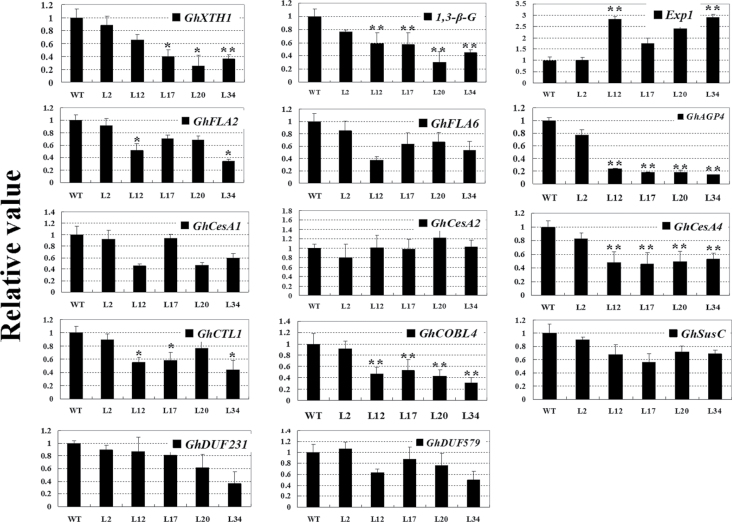
Real-time quantitative RT-PCR analysis of expression of genes related to fibre elongation and SCW synthesis in fibres of transgenic cotton plants. Total RNA was isolated from 20 DPA fibres of transgenic cotton plants (L2, L12, L17, L20, and L34) and the wild type (WT) and analysed by real-time quantitative RT-PCR; GhUBI1 was used as a quantification control. Expression levels of fibre development-related genes in transgenic plants were normalized compared with WT. The examined genes were XHT1 (xyloglucan endotransglycosylase/hydrolase 1), 1,3-β-G (1,3-β-glucanase), Exp1 (expansin1), FLA2 (fasciclin-like arabinogalactan protein 2), FLA6 (fasciclin-like arabinogalactan protein 6), AGP4 (arabinogalactan protein 4), CesA1 (cellulose synthase A1), CesA2 (cellulose synthase A2), CesA4 (cellulose synthase A4), COBL4 (COBRA-like protein 4), DUF579 (domain of unknown function family gene 579), DUF231 (domain of unknown function family gene 231), CTL1 (chitinase-like protein 1) and SusC (sucrose synthase C). Data are mean and standard deviation of three biological replicates of plant materials, and three technical replicates in each biological sample. Independent t-tests demonstrated that there were significant differences (*P<0.05) or very significant differences (**P<0.01) in gene expression between transgenic plants and the wild type.